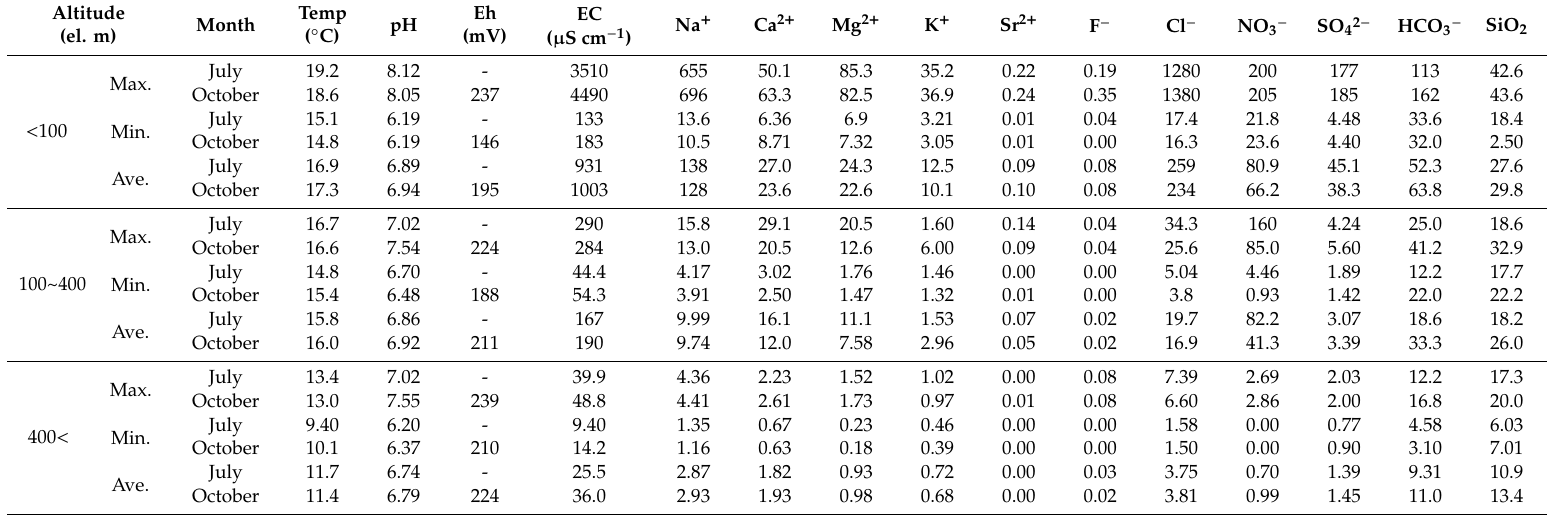
Table 2. Statistical data of chemical compositions of spring water samples according to the altitude in Jeju Island (Unit: mg / L). Altitude (el. m) Max. < 100